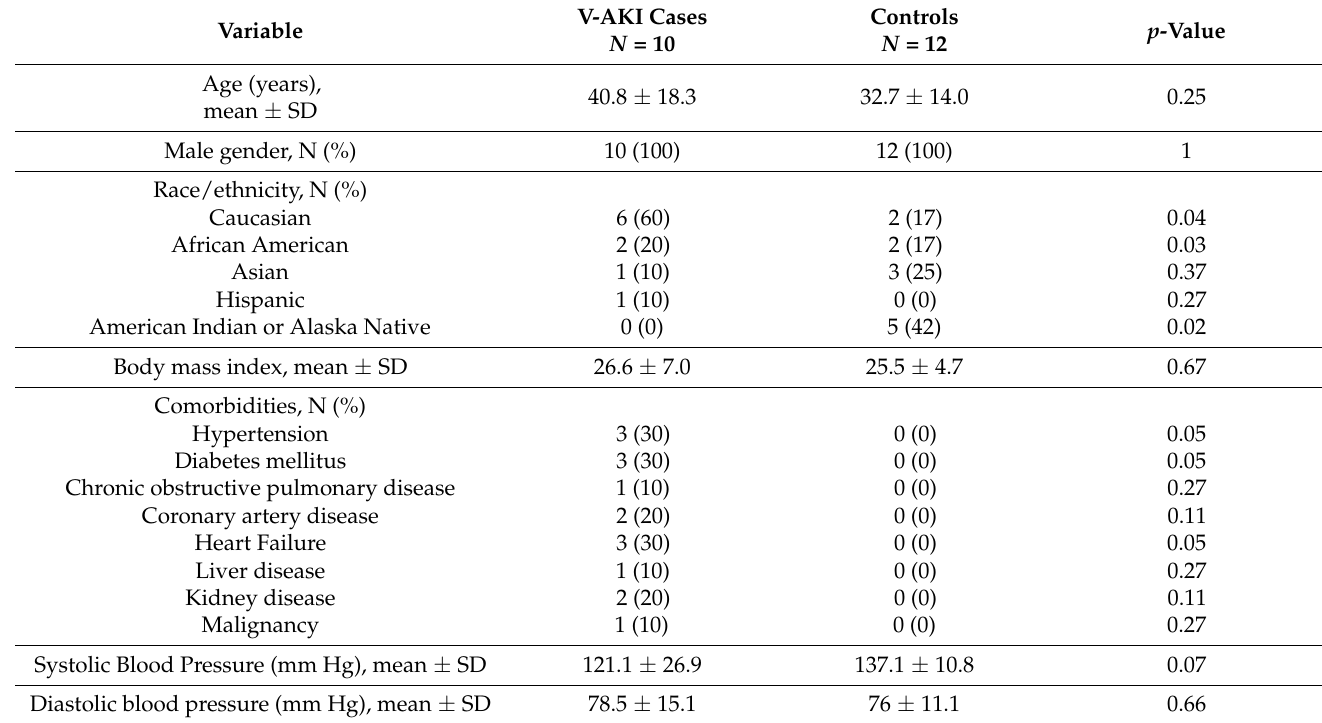
Table 1. Demographics of Vancomycin-induced Acute Kidney Injury (V-AKI) Cases and Controls.